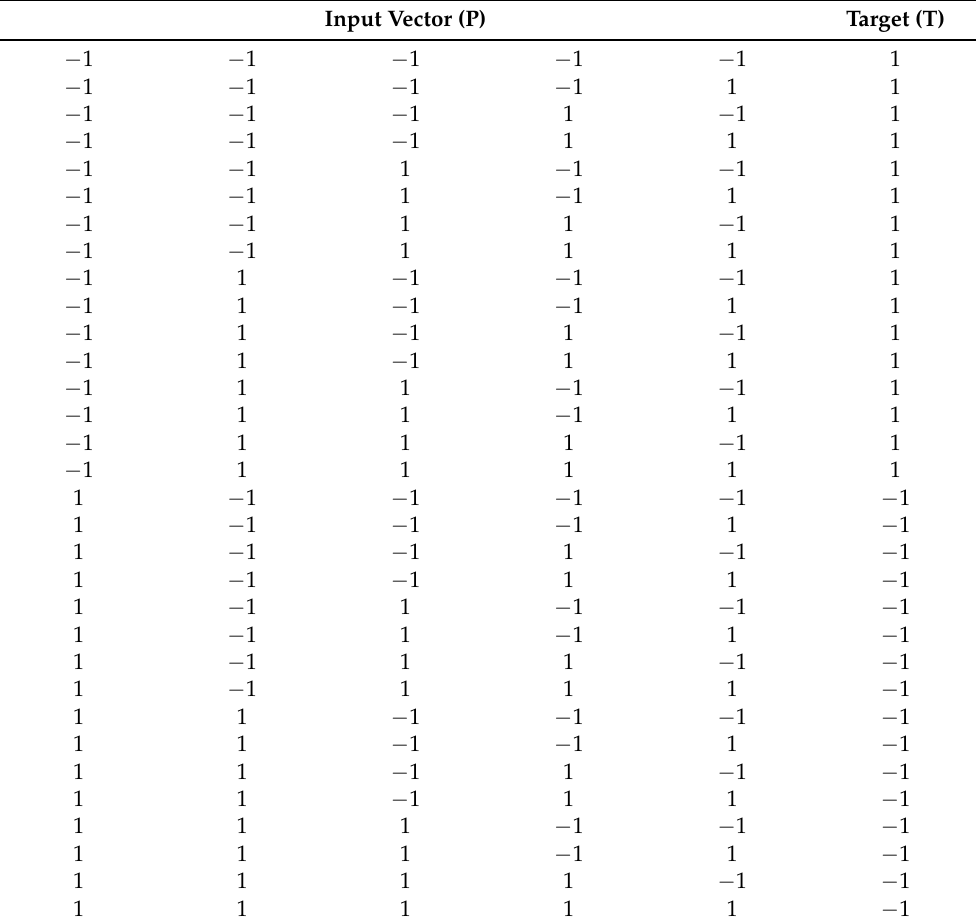
Table 7. Bipolar input